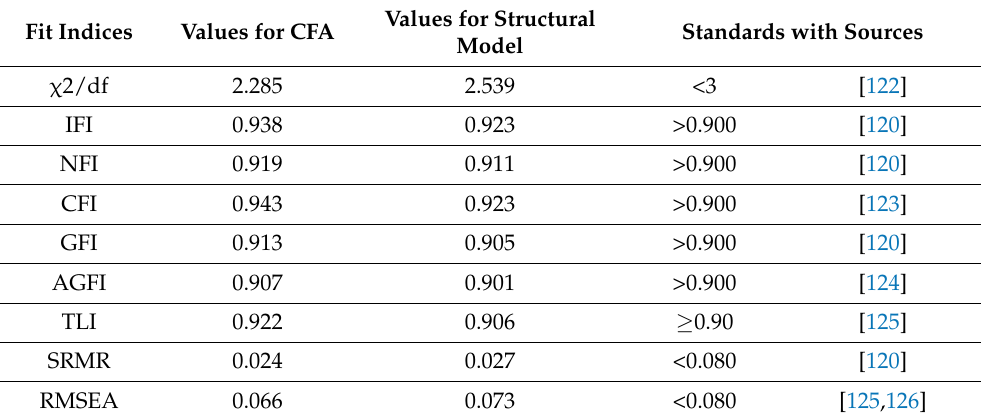
Table 5. Results of CFA and structural model with